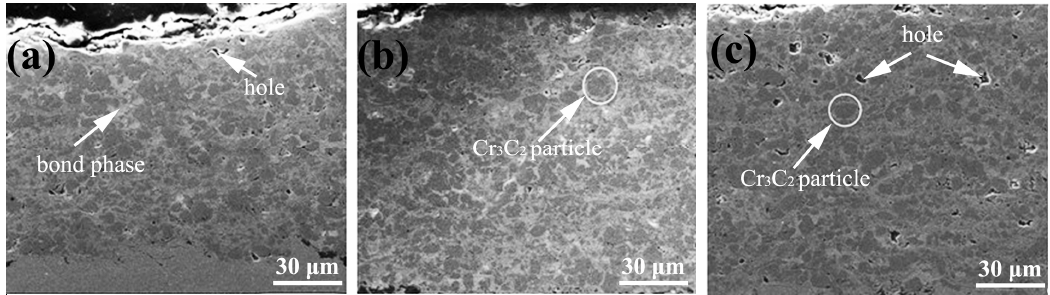
Figure 2. SEM micrographs of the three coatings ( a ) coating -A , ( b ) coating -B , ( c ) coating -C .